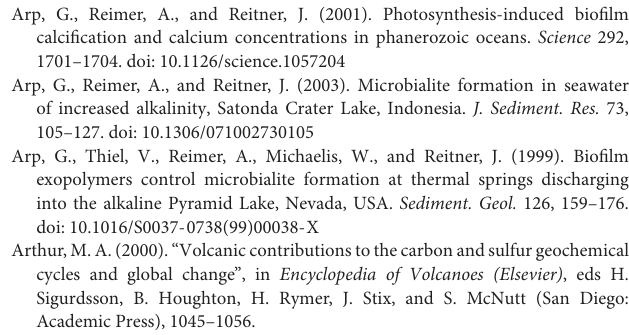
TABLE S4 | The “Precambrian marine carbonate isotope database: Version 1.1” (or PMCID) (Shields and Veizer, 2002). Labels of columns have been altered for convenience during data